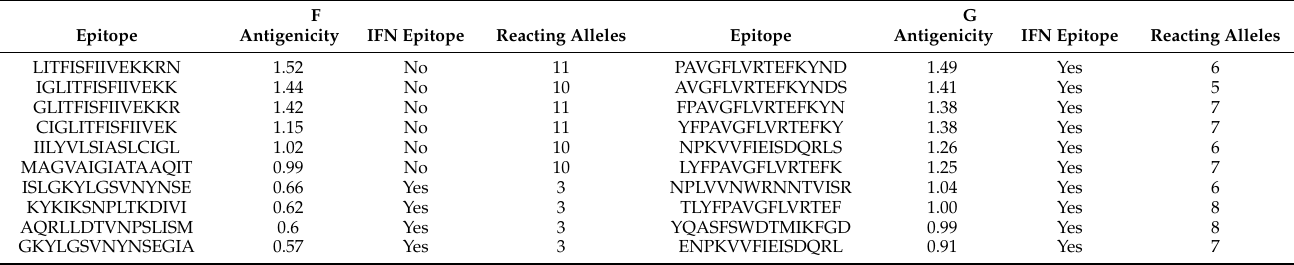
Table 4. Top-ranked T cell epitopes (MHC-II peptides) of F and G